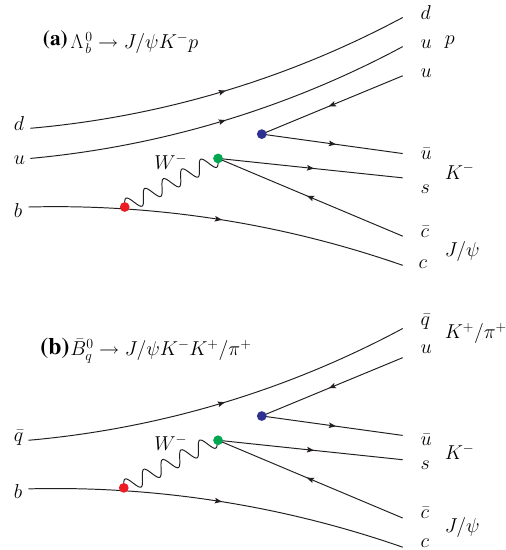
Fig. 1 Internal W -emission in (a) the (cid:5) b → J /ψ K − p decay, and (b) the ¯ B 0 → J /ψ K − π + and ¯ B 0 s → J /ψ K − K + . The diagram for the charge conjugate channel of B + → J /ψφ K + can be obtained with u ¯ u → s ¯ s in (b)